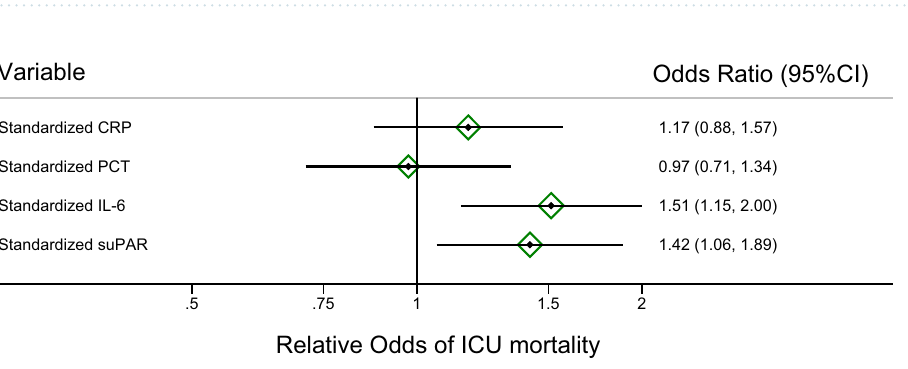
Figure 1. Z-standardized biomarkers for prediction of ICU mortality. z-standardization = all four biomarkers standardized to a mean of zero and a standard deviation (SD) of 1. Note that the hollow green diamonds represent the odds ratio for the respective biomarker, and the associated bars represented the 95% confidence interval. The black vertical line represents an odds ratio of 1 (“line of unity”). ICU = intensive care unit; CI = confidence interval; suPAR = soluble urokinase plasminogen activator receptor; CRP = C-reactive protein; PCT = procalcitonin; IL-6 =